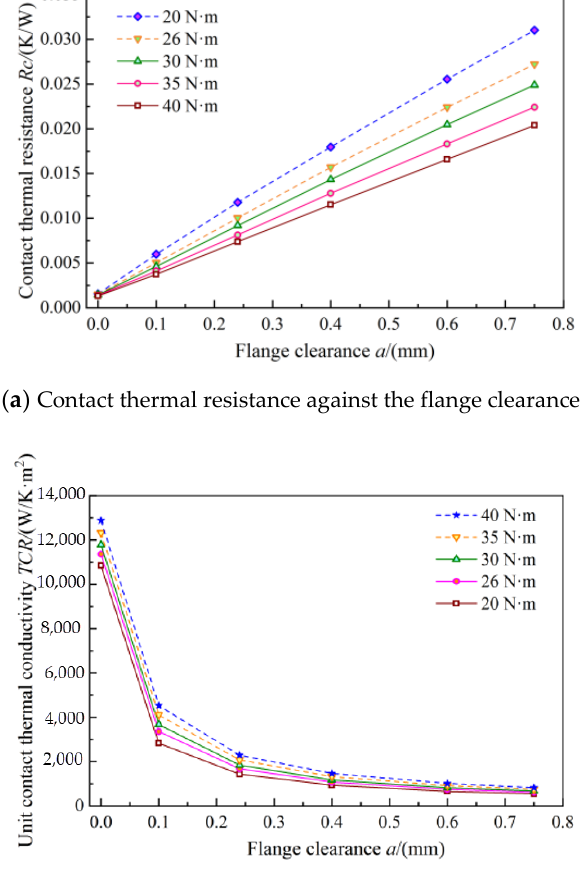
Figure 12. Effect of flange clearances with contact thermal resistance and thermal conductivity at different tightening torques for the Q345R – Q345R material.